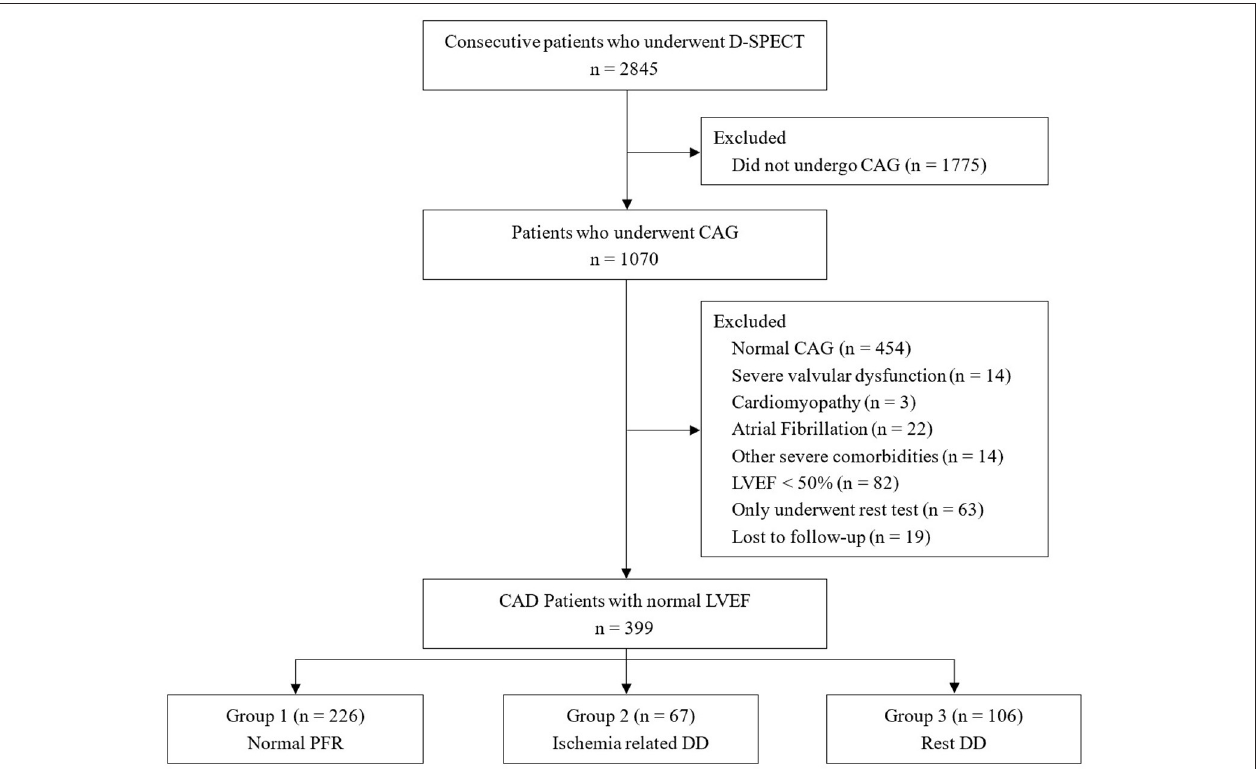
FIGURE 1 | Study flowchart. CAG, coronary angiography; LVEF, left ventricular ejection fraction; CAD, coronary artery disease; DD, diastolic dysfunction.